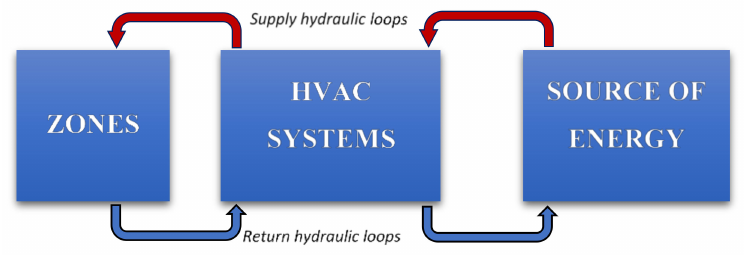
Figure 2. A diagram of the calculation process in